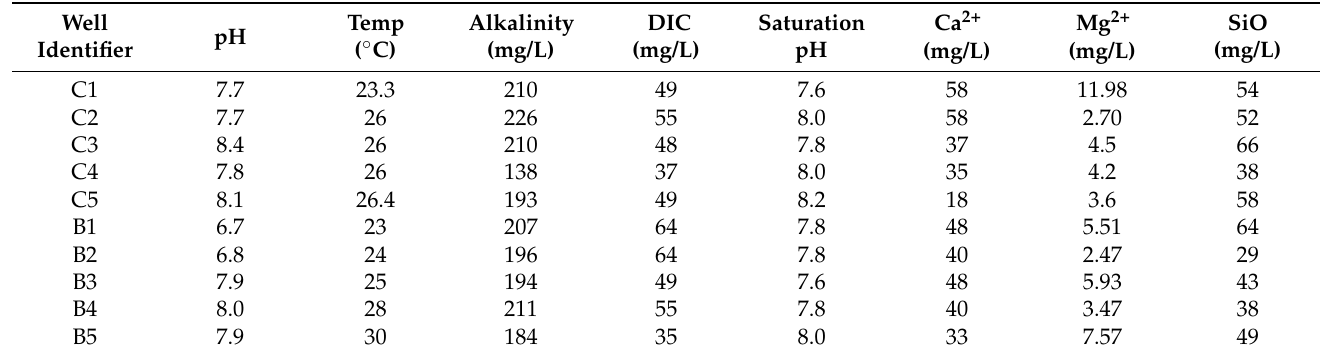
Table 5. DIC estimation and pH